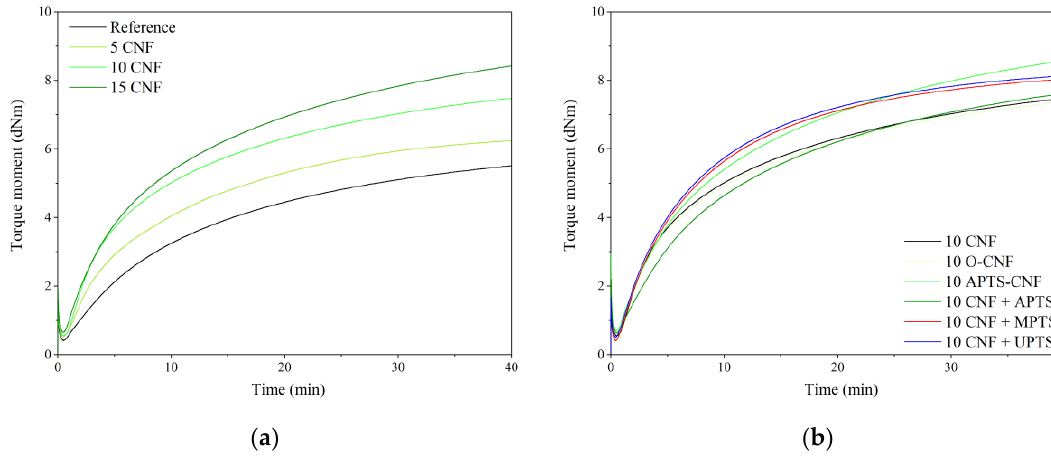
Figure 6. Cure curves for acrylonitrile-butadiene rubber (NBR) compounds filled with ( a ) different loadings of CNF, and ( b ) CNF modified with different silanes. Table 1. Rheometric parameters obtained for CNF-filled